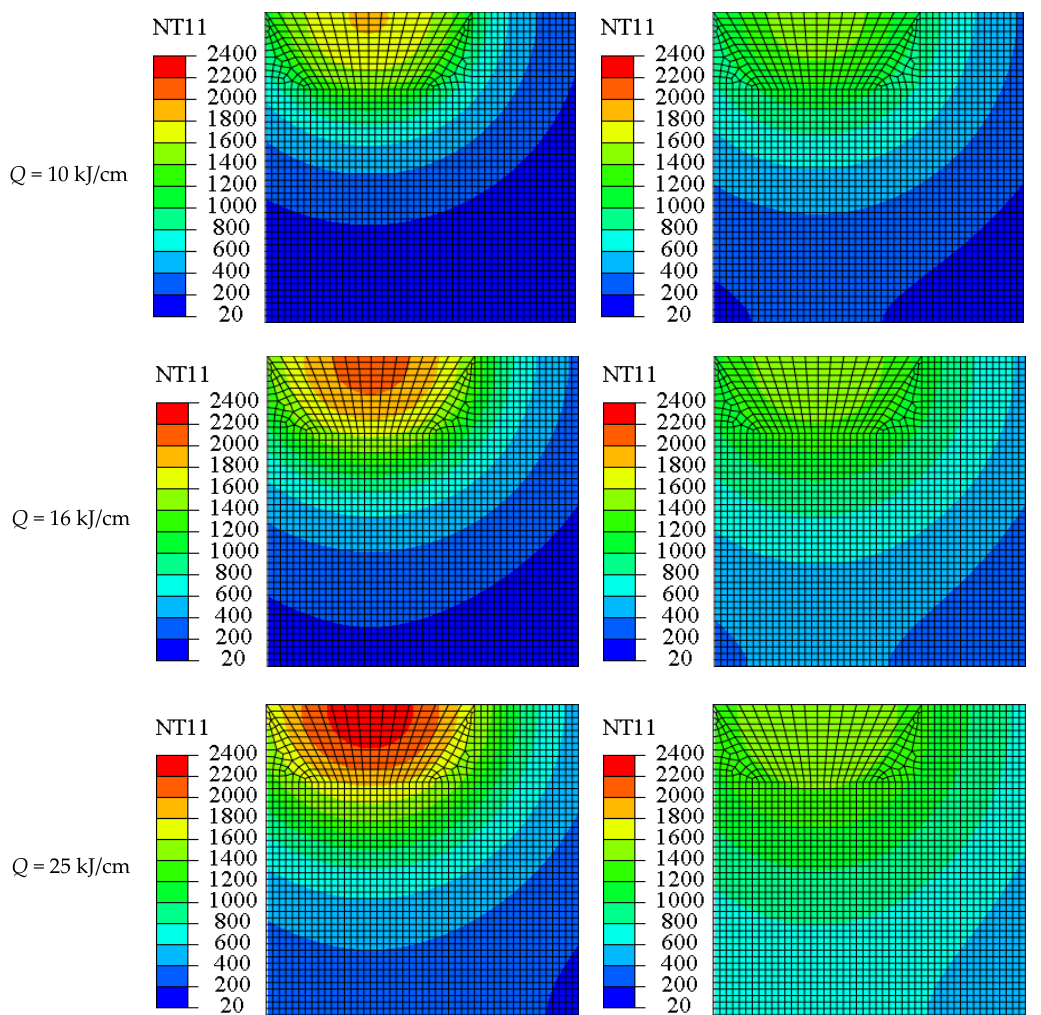
Figure 16. Temperature contours at the intermediate instant and the end instant of repair welding for different linear energy.